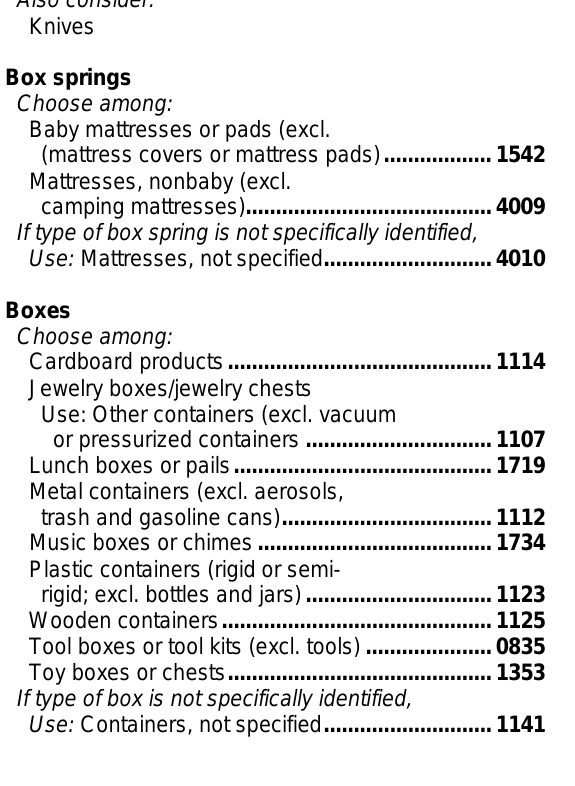
Box jumping (exercise) Use: Exercise equipment (excl. weight